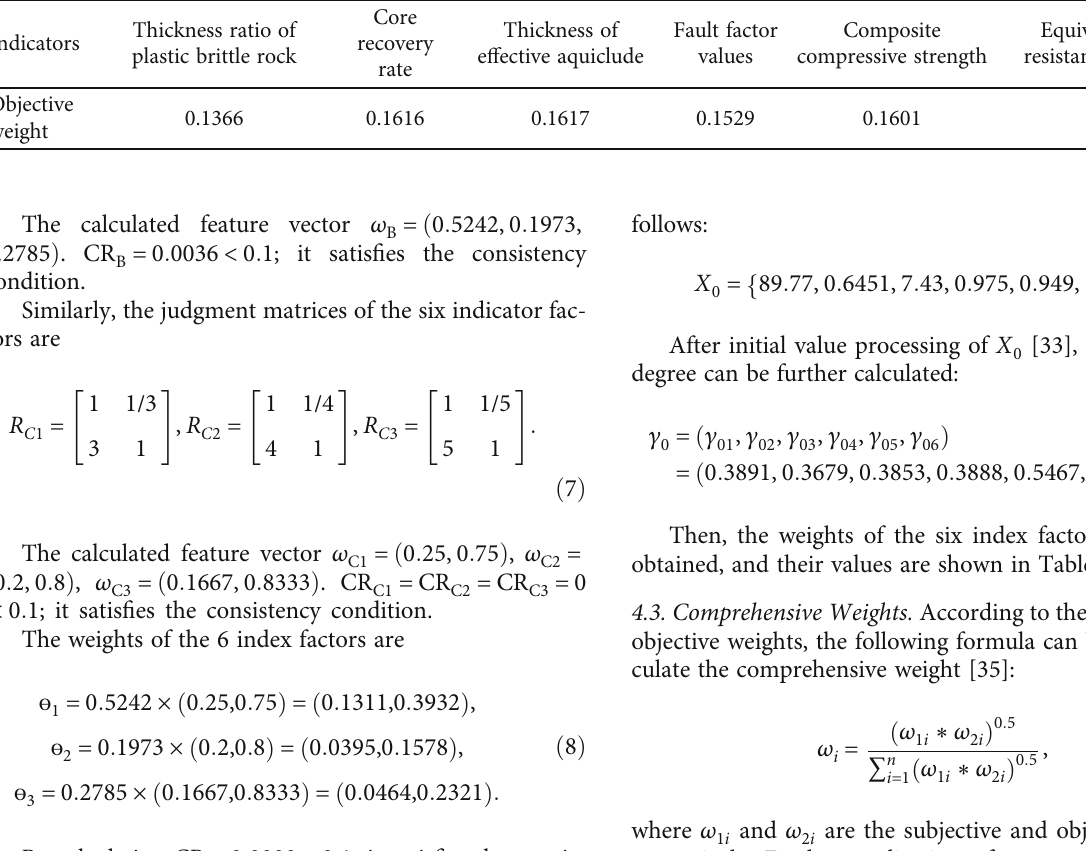
Table 8: Objective weight from the grey correlation analysis